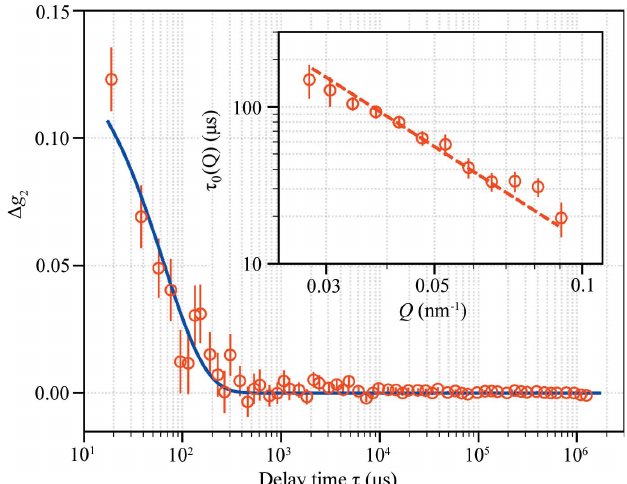
Figure 3 Intensity autocorrelation function (cid:2) g 2 = g 2 (cid:2) 1 averaged over 14328 repeated measurements from sample A. The blue solid line shows the fitting of (cid:2) g 2 = (cid:5) exp[ (cid:2) 2 (cid:2) / (cid:2) 0 ( Q )]. The inset shows the fit with the Stokes– Einstein equation (cid:2) 0 ( Q ) = 1/( DQ 2 ) (red dashed